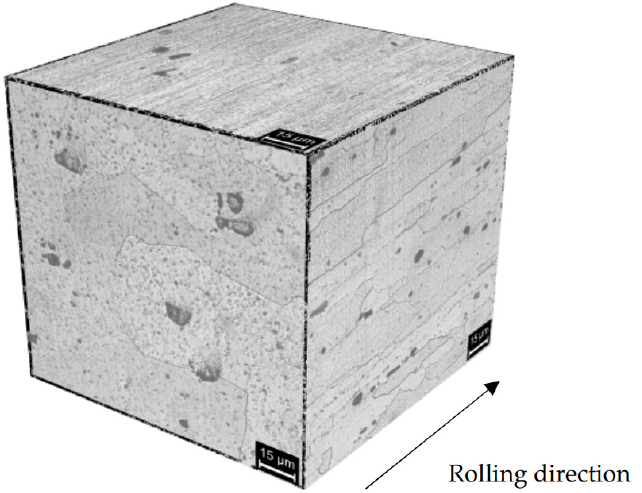
Figure 4. Optical image (Keller attack) of the alloy AA 7075 T6 (base material). Elongated grains along the rolling direction and the macro-precipitates are visible.